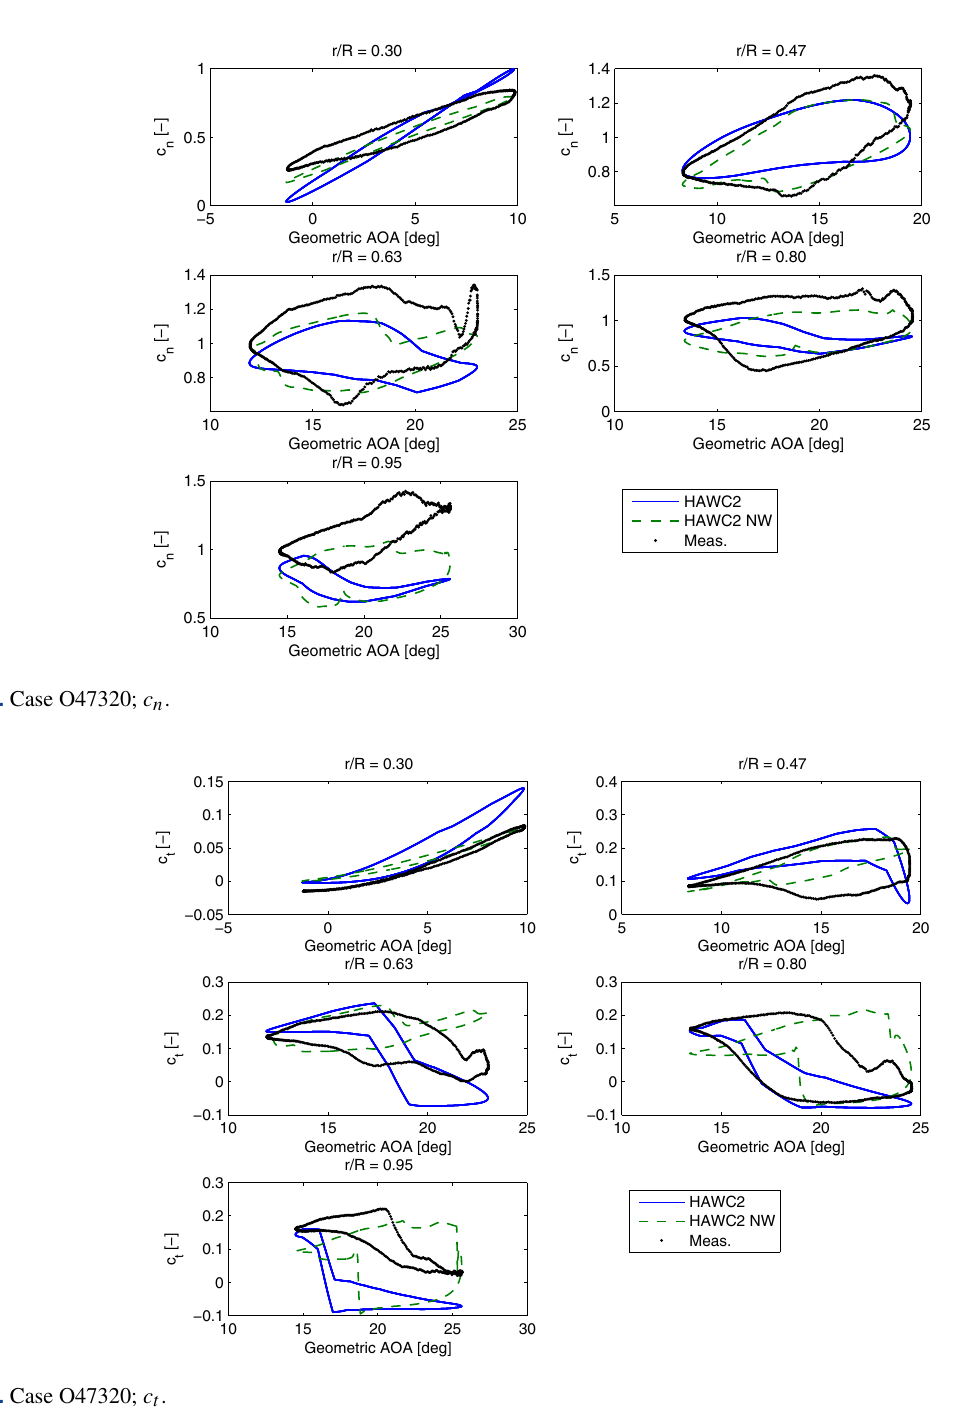
increases towards the tip. These increased induced velocity variations counteract the force variations due to inflow tur- bulence, which causes slightly smaller standard deviations of the angle of attack and flapwise force if the trailed vorticity modeling is active. There is no clear tip vortex visible in the mean induction distribution because the loading approaches zero towards the tip even without an induction model. Fur-